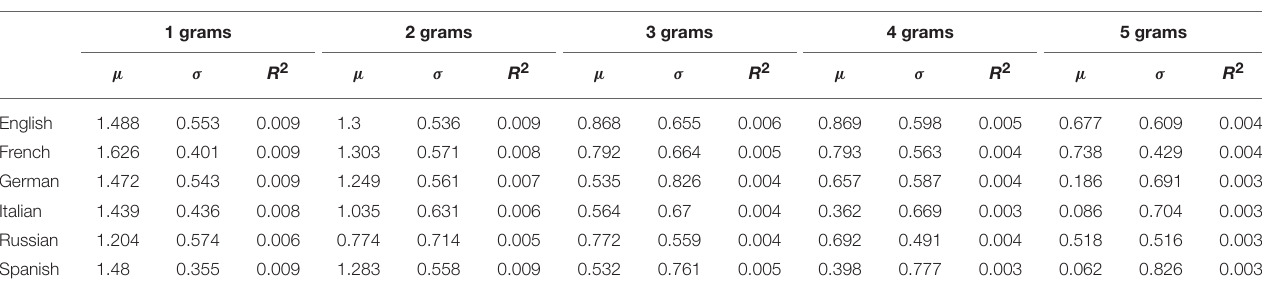
TABLE 2 | Fit parameters for change probability for different